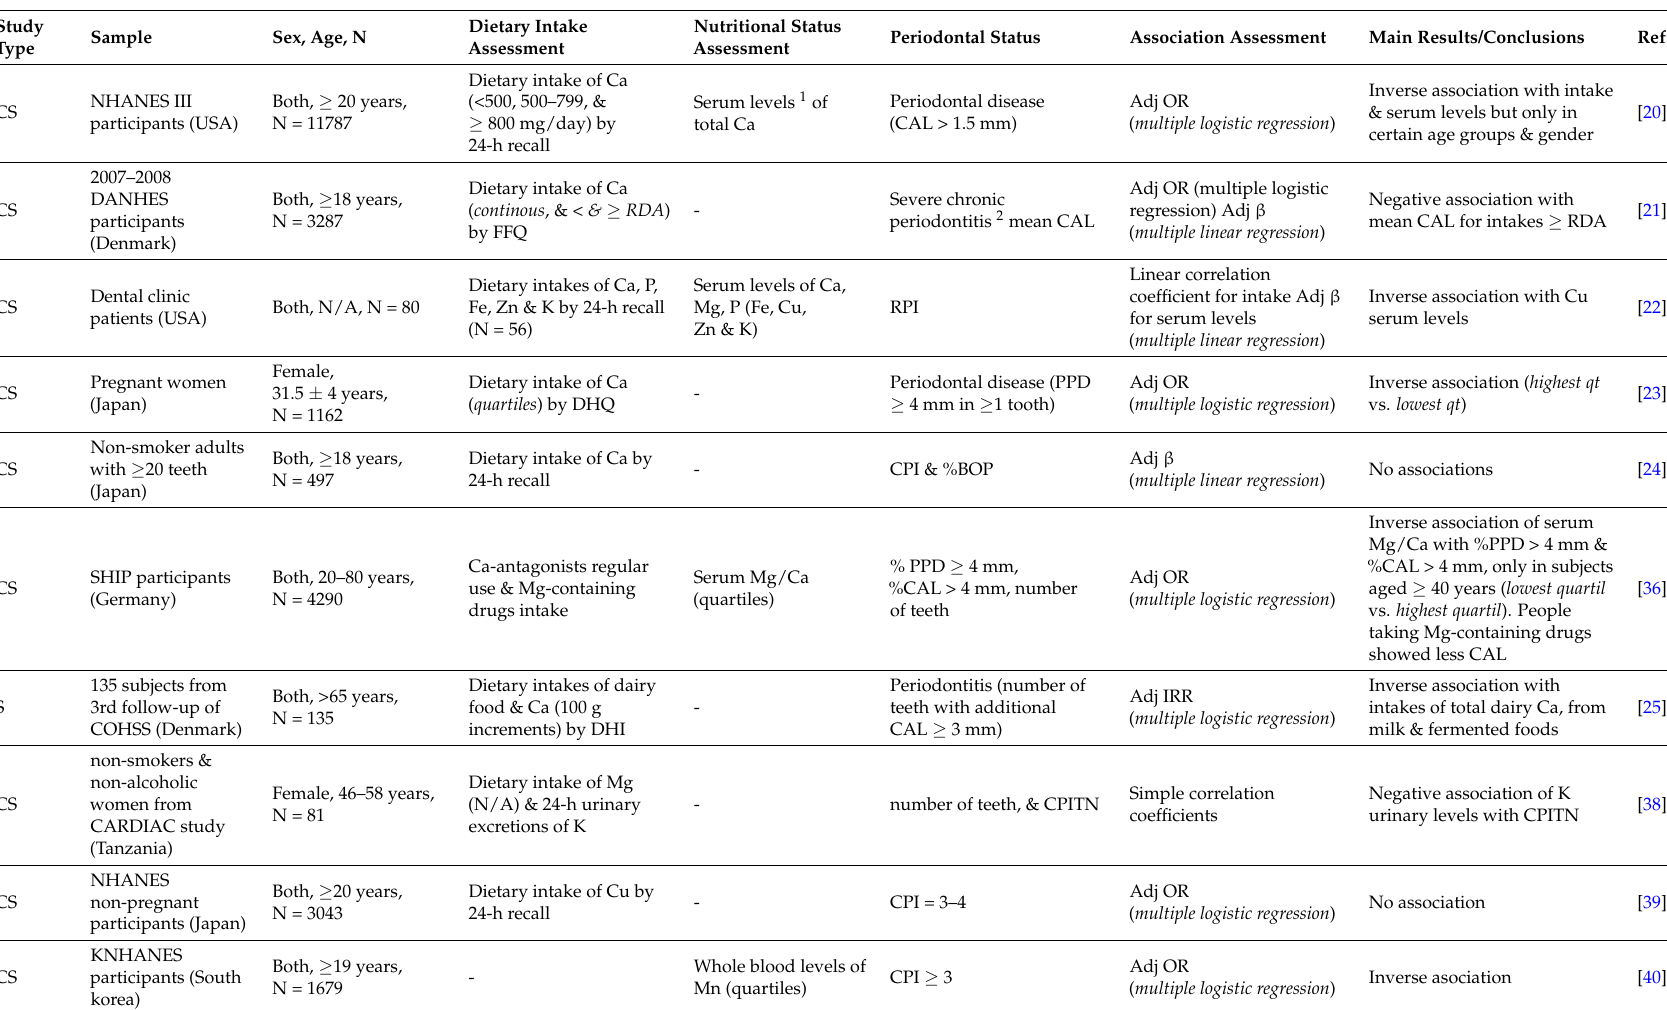
Table 1. Observational studies on minerals’ associations with periodontal